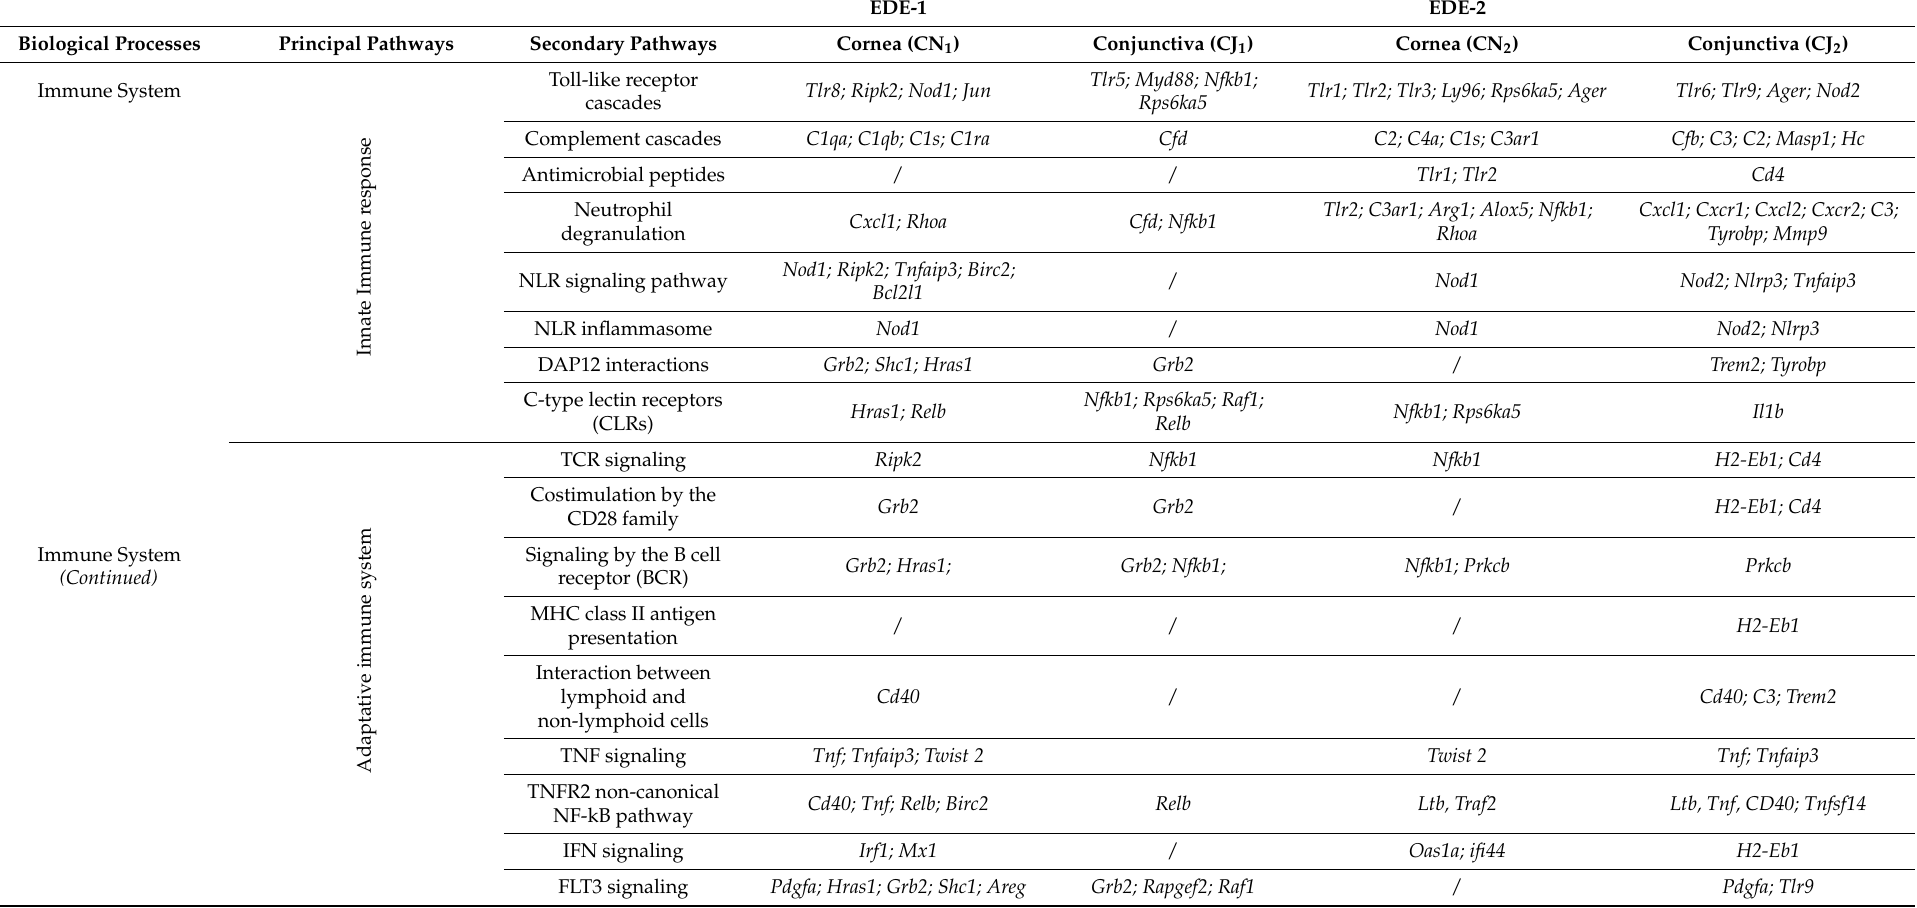
Table 4. Comparison of molecular targets involved in EDE. Summary of differentially expressed genes in corresponding signaling pathways in both experimental mouse